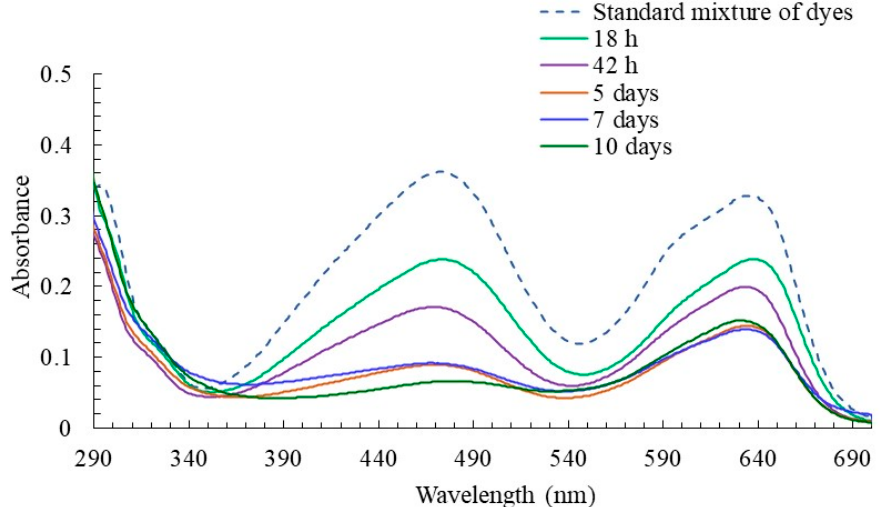
Figure 11. UV spectra of dye solution added on top of the gel compound 7a at 8.0 mg/mL in DMSO:H 2 O ( v/v 1:5) monitored over time. The standard solution of 0.02 mM toluidine blue and 0.012 mM methyl orange were used. The absorption at 635 nm for Toluidine Blue and 465 nm for Methyl Orange were used to calculate the percentage of dye absorbed. Formula used: % Dye absorbed = 100 − [(A solution )/A standard ]*100.